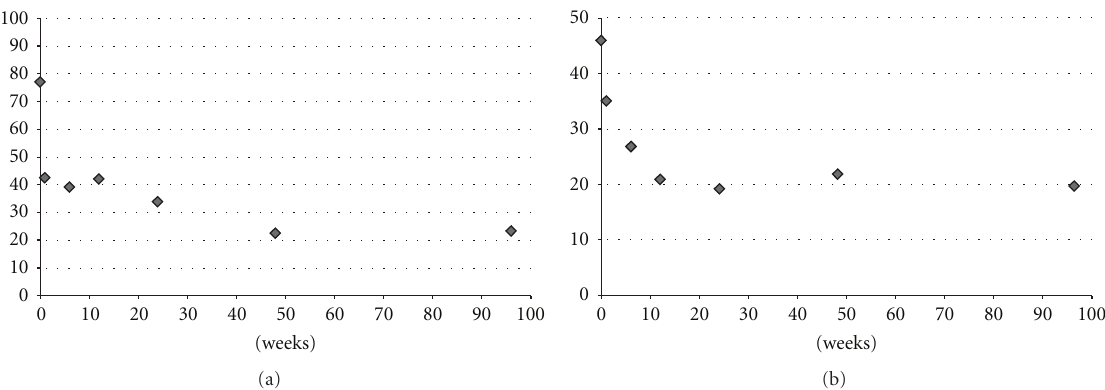
Figure 1: Clinical outcomes. (a) VAS back pain scores, all postoperative results are statistically significant compared to baseline ( P < 0 . 003). (b) ODI scores, results are statistically significant since 1-week followup ( P < 0 . 04) and in other postoperative visits ( P < 0 . 001) compared to baseline.